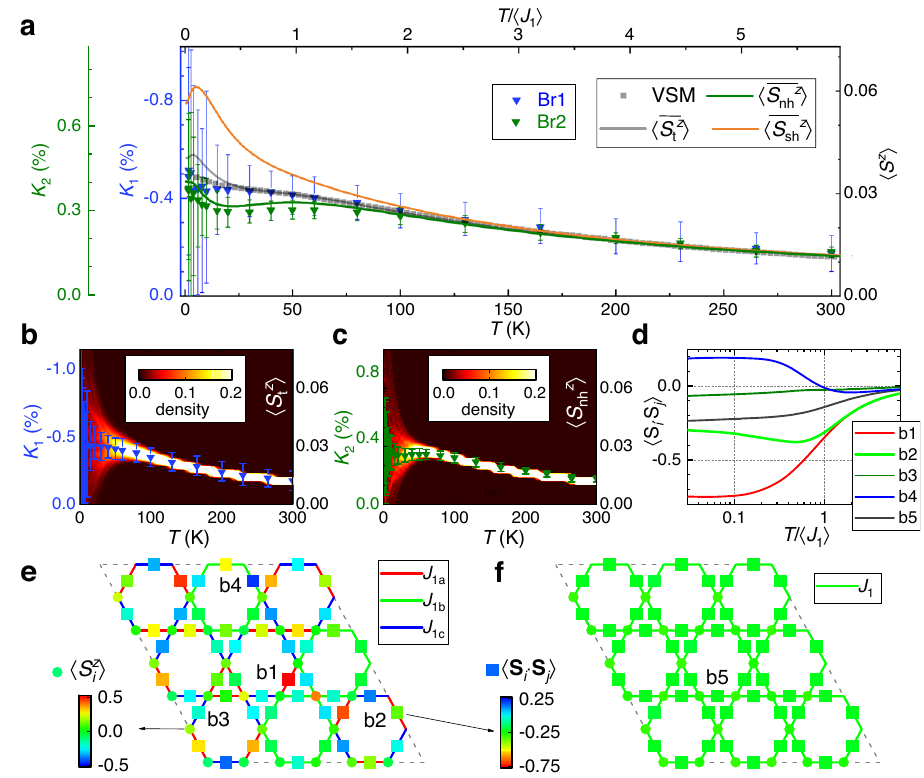
Fig. 3 Simulations of the spatially inhomogeneous susceptibility probed by nuclear magnetic resonance (NMR) spectra. a Temperature dependence of NMR shifts K 1 and K 2 , as well as bulk 〈 S z 〉 measured in a vibrating sample magnetometer at a fi eld μ 0 H ∥ = 10.75 T. The colored lines show the calculated i ), nonsymmetric hexagons ( h S z i ), and symmetric hexagons ( h S z i ). b , c The fi nite-temperature Lanczos average 〈 S z 〉 over all the triangles ( h S z t nh sh i ) and nonsymmetric hexagons ( h S z i ), along with the measured K K diagonalization results of local magnetization of triangles ( h S z 1 and 2 , respectively. t nh d Calculated local correlations of the selected spin pairs ( e , f ) as function of normalized temperature T / 〈 J 1 〉 . e Calculations of a sample within the random kagome Heisenberg antiferromagnet (KHA) model at T = 0.1 〈 J 1 〉 and μ 0 H ∥ = 10.75 T. The solid circles and squares stand for local magnetization h S z i i at the kagome site i and correlation function 〈 S i ⋅ S j 〉 of the nearest-neighbor spin pair 〈 ij 〉 , respectively. f The same calculations as in e , but within the ideal KHA model. The dashed lines mark the clusters with periodic boundary conditions, and J 1a , J 1b , J 1c , and J 1 present the exchange couplings. The color scale in b and c quanti fi es the distributed density, whereas the ones in e and f quantify the local magnetization (circles) and correlation function (squares), respectively. The bars in a – c show the regions where the intensities are larger than half of the maximum